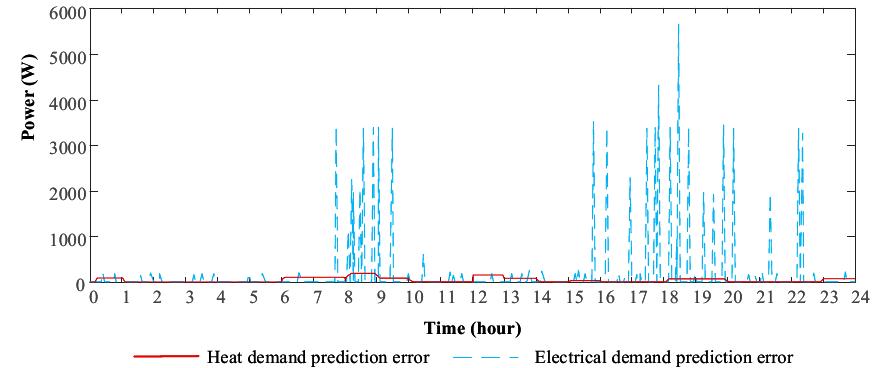
Figure 8. Heat and electrical demand prediction error by using proposed prediction algorithm.